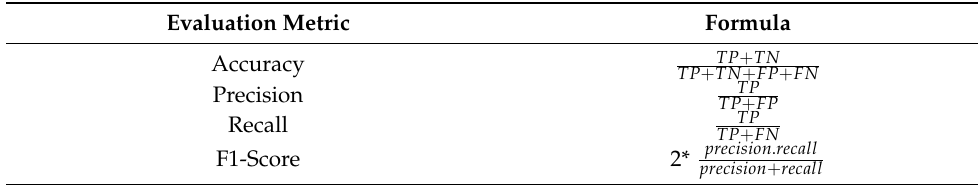
Table 4. Performance measures used for evaluation in this